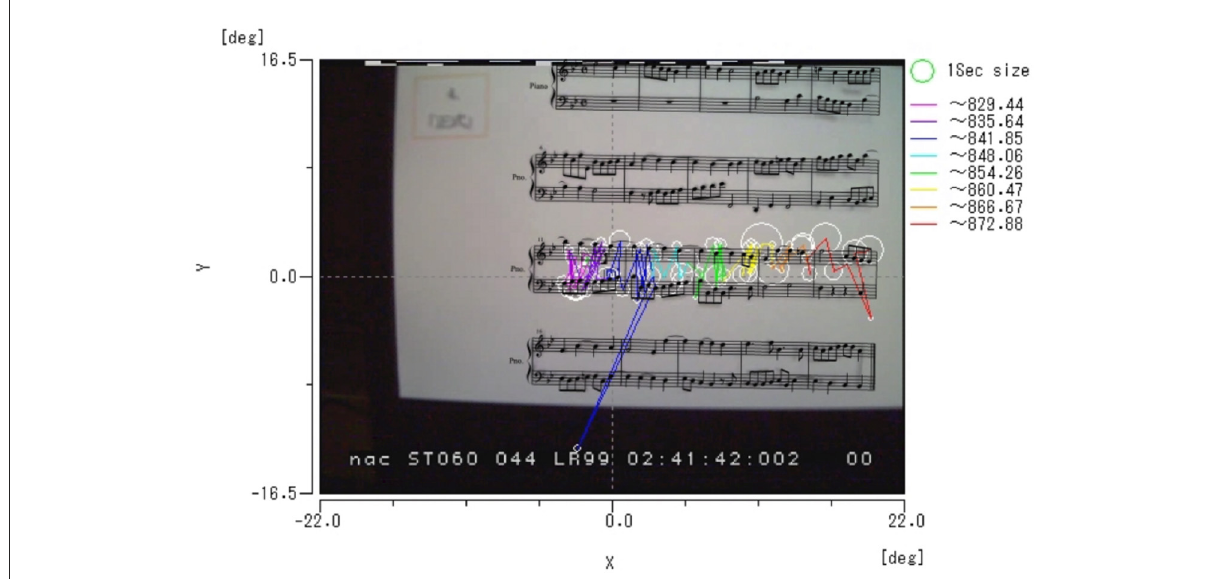
FIGURE1 An example of visualization of eye tracking while one participant was playing the third row of score HM. The size of white circle represents the duration of each fixation with the size of green circle on the right column as 1s (i.e., 1,000ms). Lines with different colors show traces of eye tracking in time lines shown on the right column.